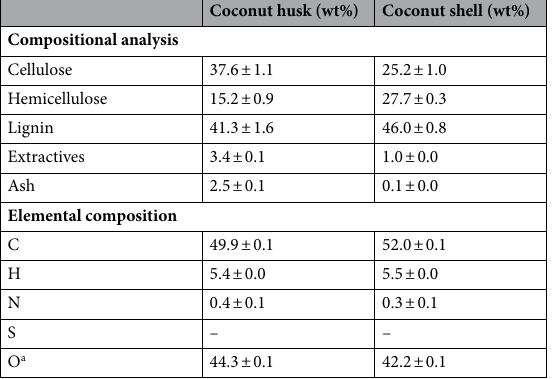
Table 1. Elemental and Chemical composition of coconut residues (based on dry wt. % basis) investigated in this study (Error bars represent standard deviations for three replicate measurements). a Calculated by difference (O = 100–C–H–N–S,